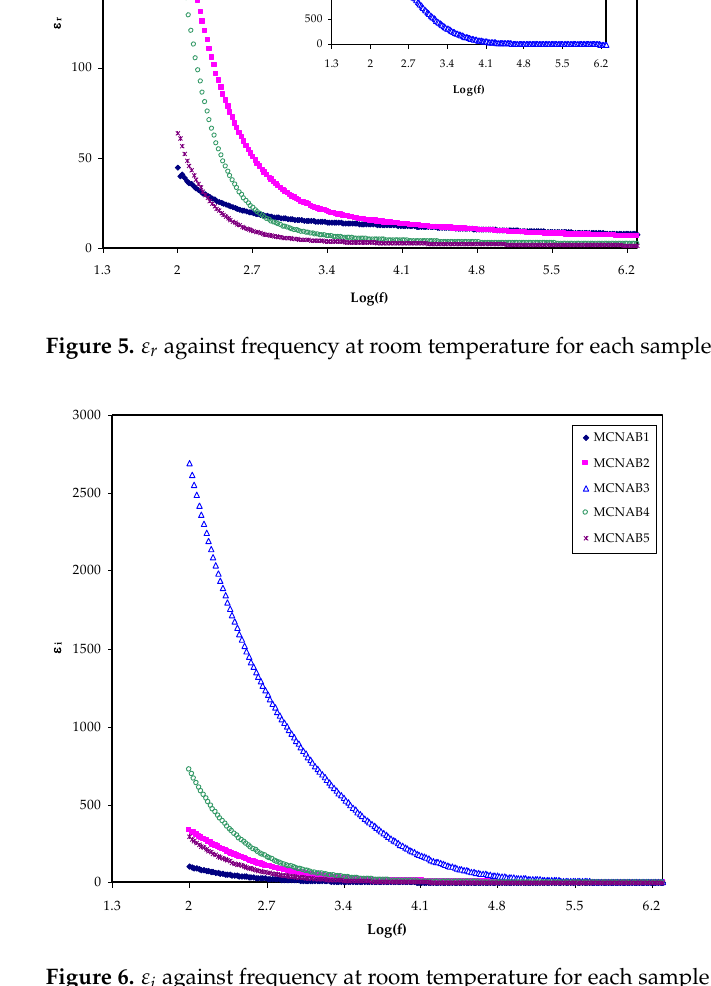
Figure 6. ε i against frequency at room temperature for each sample.